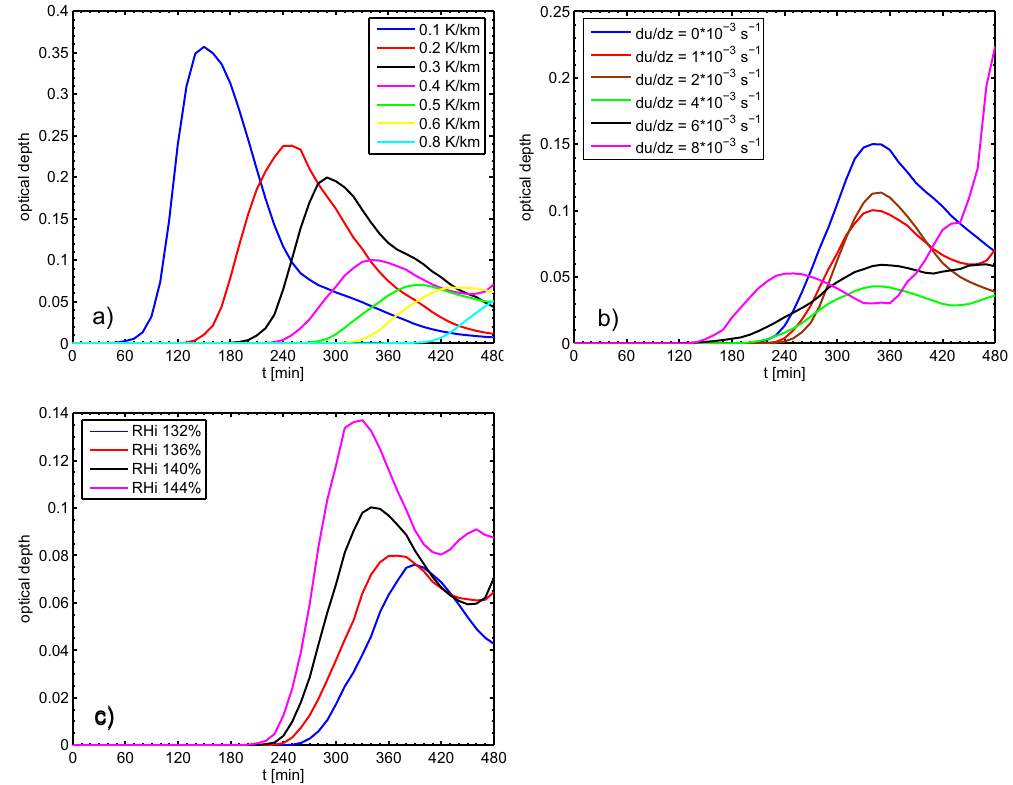
Fig. 12. Mean optical depth (as a function of time) of cirrus clouds, triggered by radiative cooling for following sensitivity studies: (a) thermal stratification; (b) dynamic stability (variation of vertical wind shear); (c) RHi, using different peak values inside the